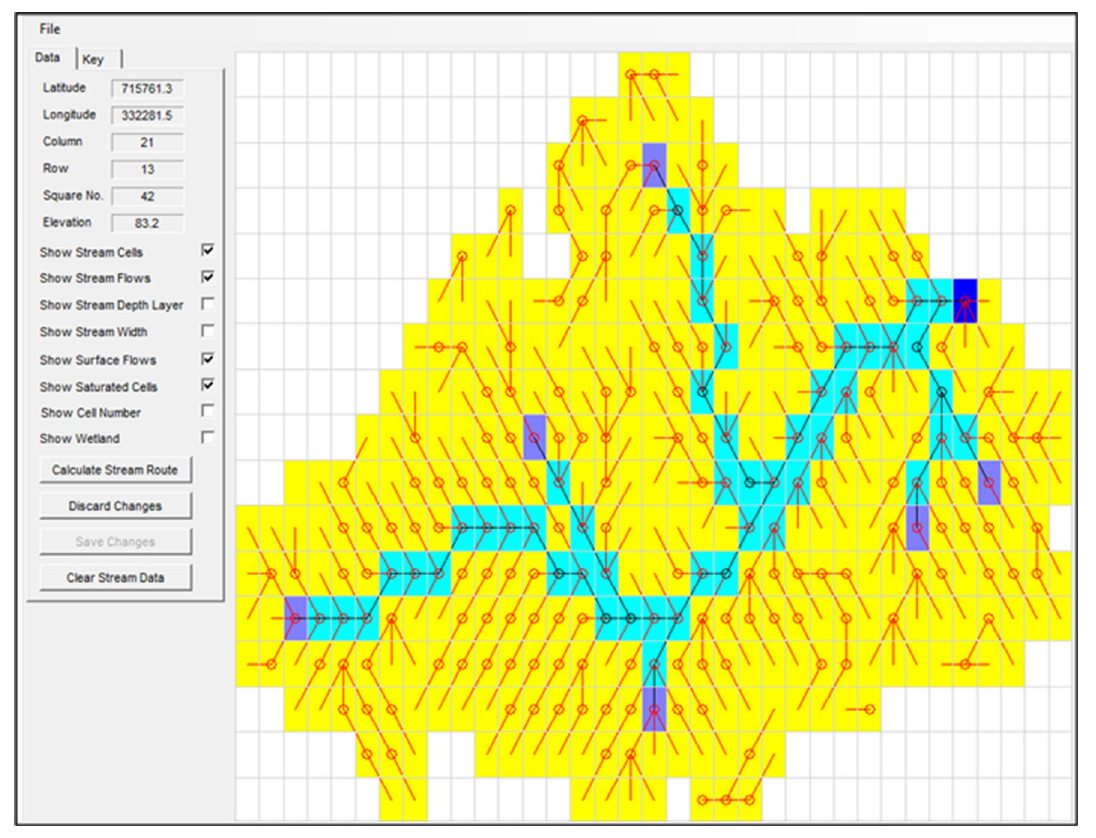
Fig. 3 Stream and surface flow map of Eden catchment generated by DiCASM